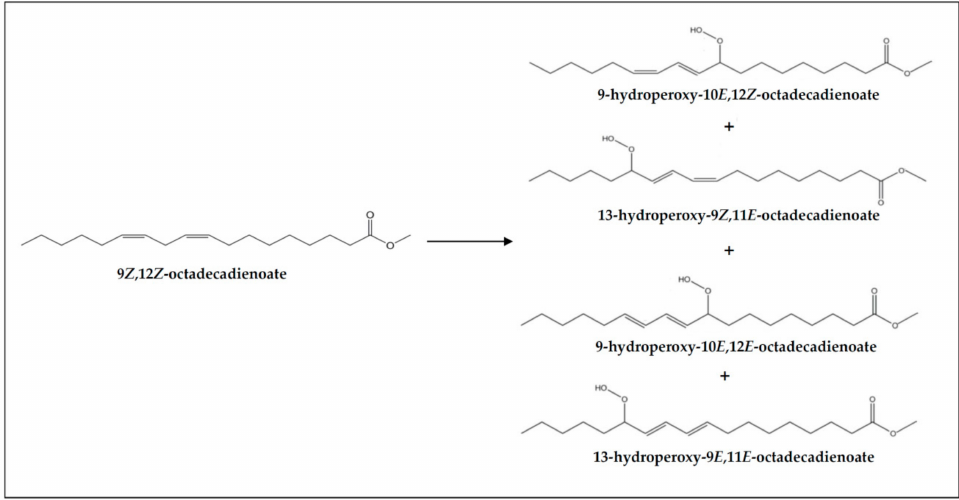
Figure 5. Monohydroperoxy-( Z , E )- and -( E , E )-conjugated octadecadienoates formed in the oxidation of 9 Z ,12 Z -octadecadienoate groups (linoleic acyl groups).